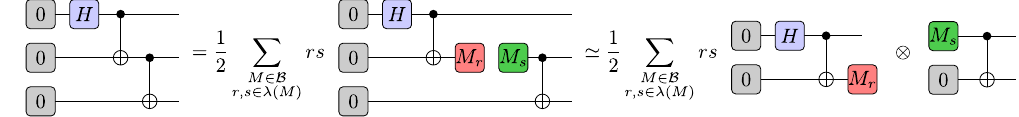
Fig. 1 Circuit cutting example. A 3-qubit GHZ circuit can be cut into two 2-qubit fragments by inserting an identity operator. Here B (cid:3) X ; Y ; Z ; I f g is the set of Pauli operators X , Y , Z and the identity I , which together form an orthogonal basis for the space of single-qubit operators; λ ( M ) denotes the spectrum of M ; and M s (cid:3) M s ih M s